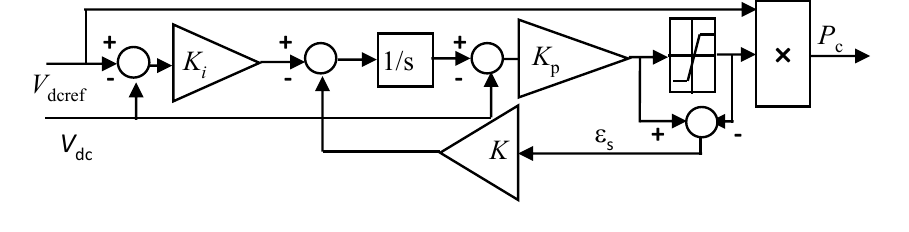
Figure 3. Simulation model of IP controller.